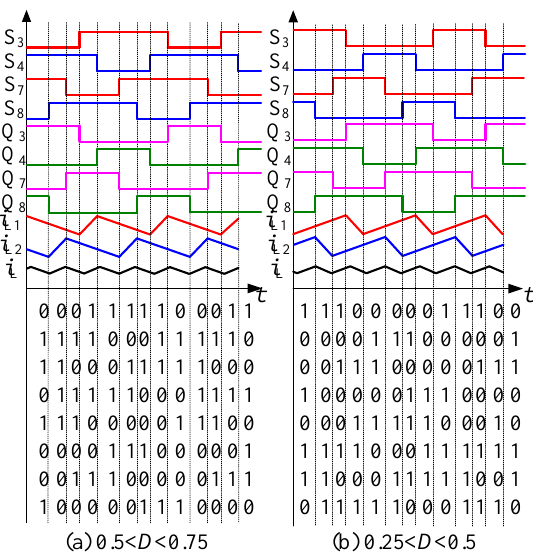
Figure 1d. The left and right parallel arms are interleaved 90° parallel modulation, and the upper and lower series arms are complementarily connected in series. For example, when 0.5 < D < 0.75, in mode 0101/1010, it means S 3 is off, S 4 is on, S 7 is off, S 8 is on; while, Q 3 is on, Q 4 is off, Q 7 is on, and Q 8 is off. The modulation rule of the BDC is shown in Figure 5.